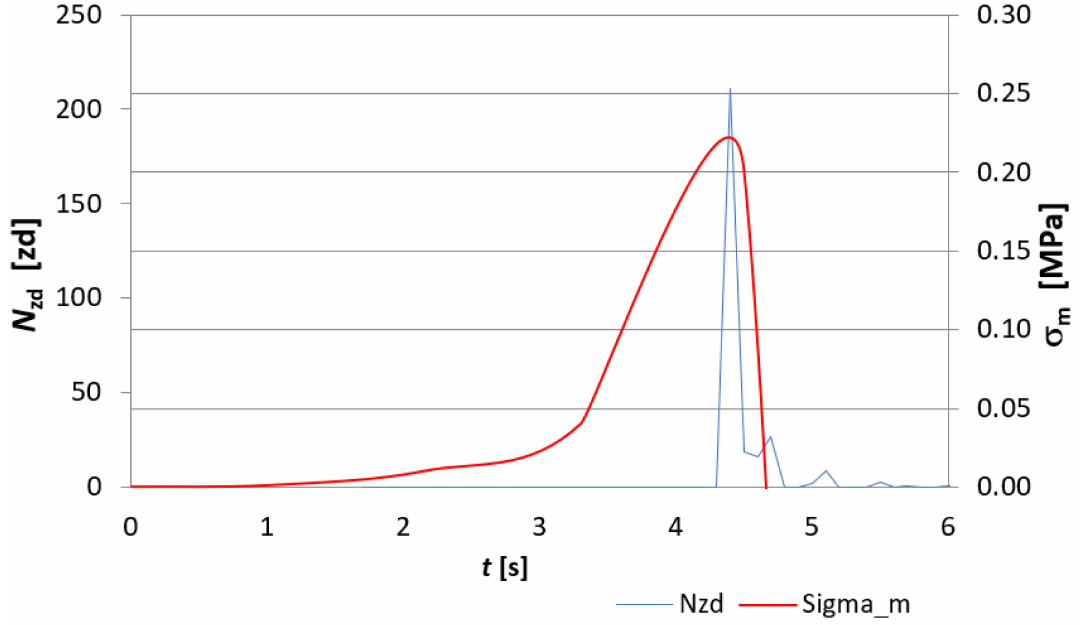
Figure 10. Recording of the event rate N zd and bending stress σ m versus time for the D5